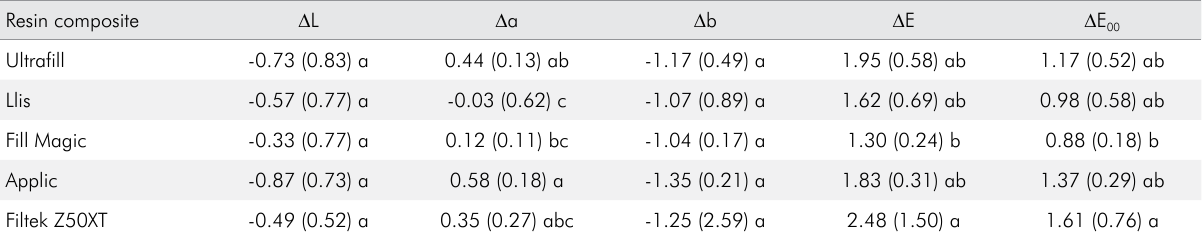
Table 4. Mean and standard deviation (SD) of difference of CIELab parameters ( Δ L, Δ a and Δ b), color change ( Δ E) and CIEDE2000 color difference ( Δ E ), after simulated tooth brushing protocol. 00